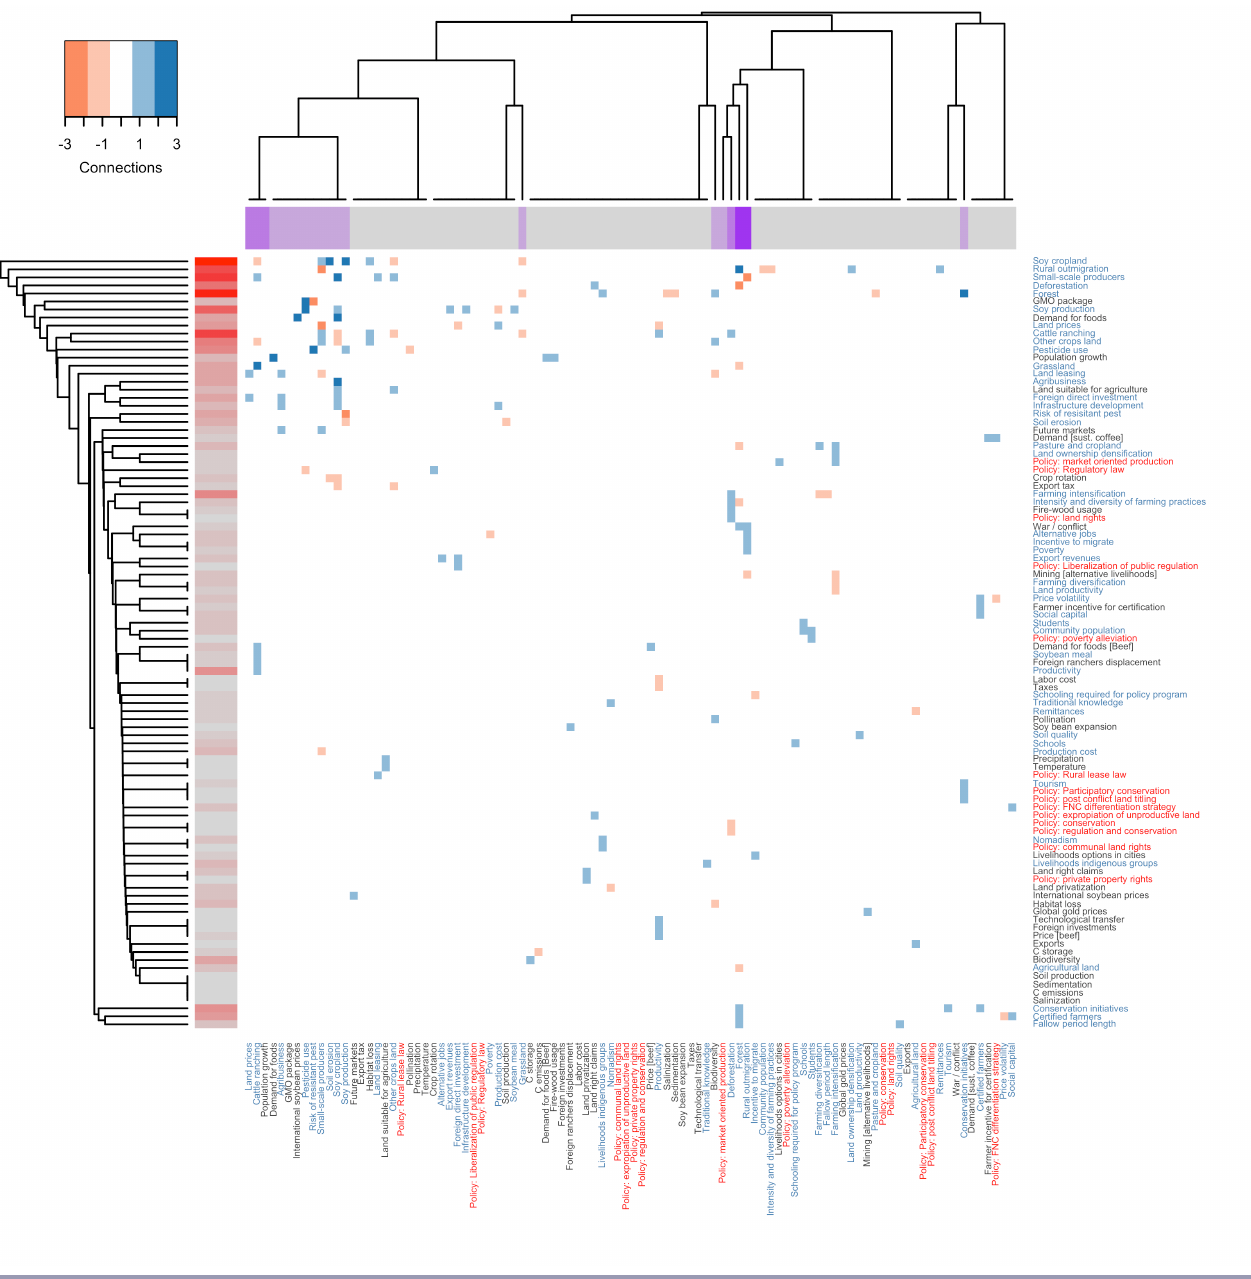
Fig. 3 . Structural equivalence analysis. The causal network for all case studies (Fig. 2a) is here represented in its matrix form. Rows are organized by hierarchical clustering according to the connections in the causal networks; two nodes are similar if they share similar neighboring variables. Columns are organized by hierarchical clustering according to the cases in which the variable is reported; nodes are similar if they occur in the same cases. The number of cases in which a node appears is reported on the horizontal color bar whereas the number of connections in the causal networks is reported on the vertical color bar. The maximum number of cases in which a particular link occurs is three. Following the color scheme of Figure 2, links are blue if positive or orange if negative. Variable names are depicted in gray if they are drivers, blue if they appear in a feedback cycle, or pink if they are a leverage point. Note: FNC is the (Spanish) abbreviation for the national association of coffee producers of